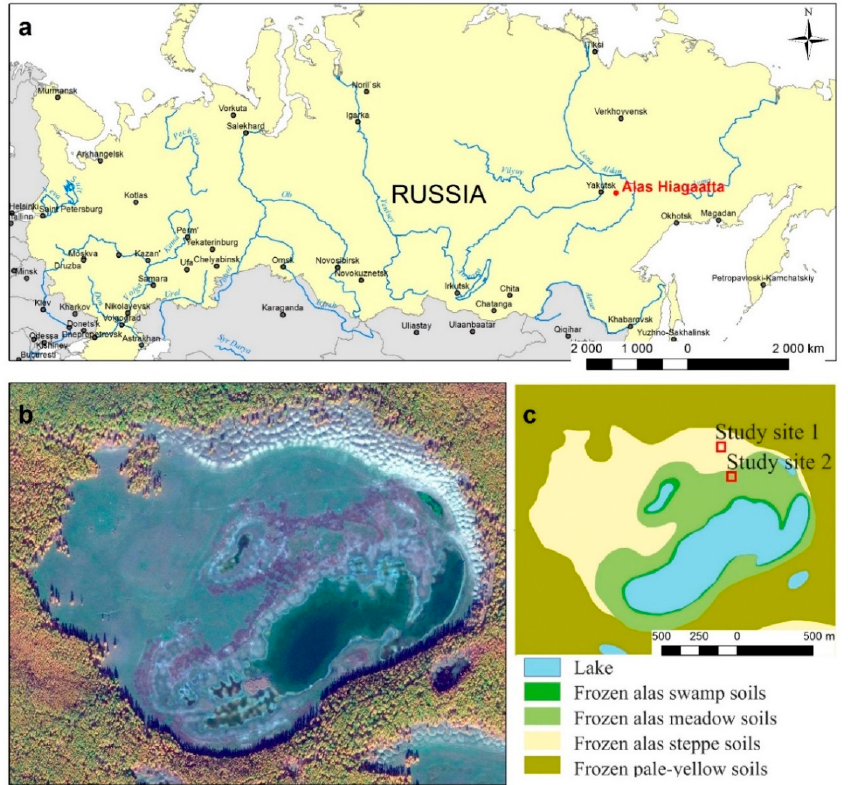
Figure 1. Location of the study area . Figure 1. ( a – c ) Location of the study